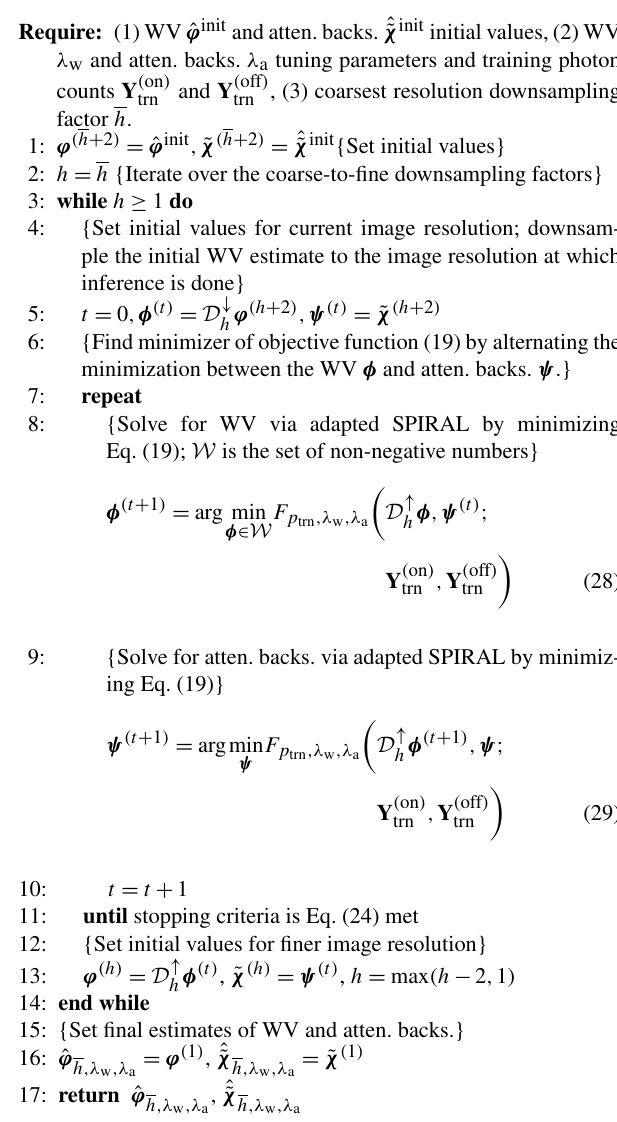
Algorithm 4 Coarse-to-fine image resolution framework for inferring WV ϕ and attenuated backscatter χ